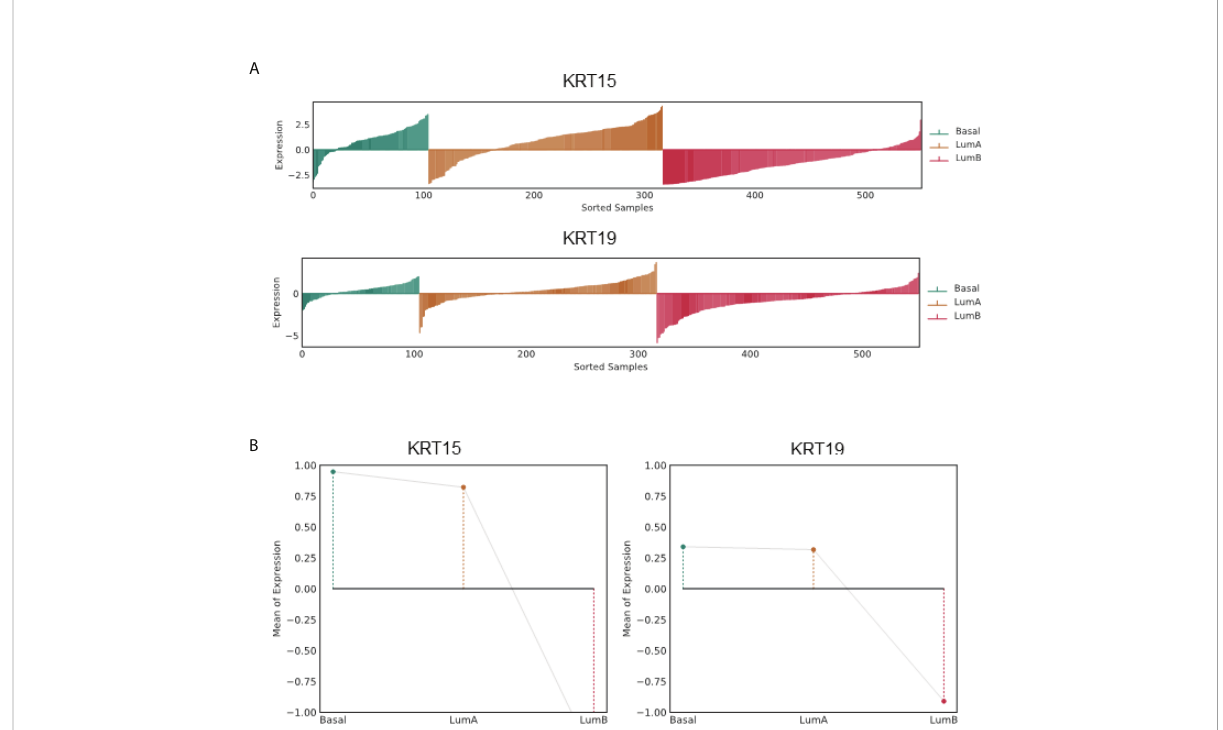
FIGURE 3 Association of KRT15 and KRT19 expression with PCa subtypes in the TCGA PCa patient cohort. (A) Lollipop plots. (B) Lineplots of mean trends. All analyses were performed in PCTA (24) using the default